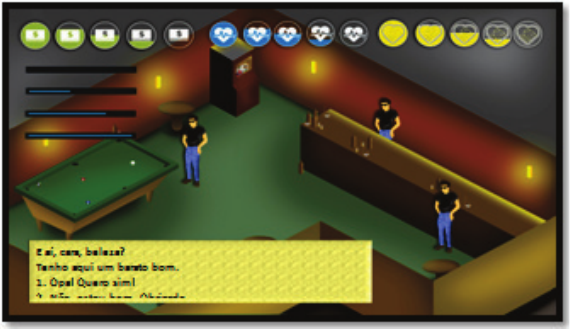
Fig. 12. Screenshot of the prototype of therapeutic game for chemical dependency (bar scenario).